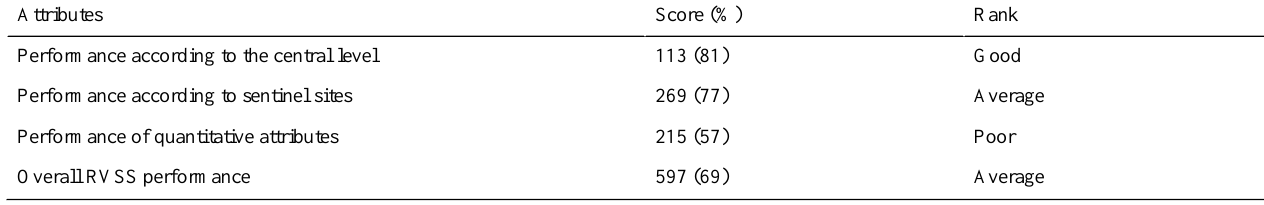
Table 6. Summary of the overall performance of the Rotavirus Surveillance System